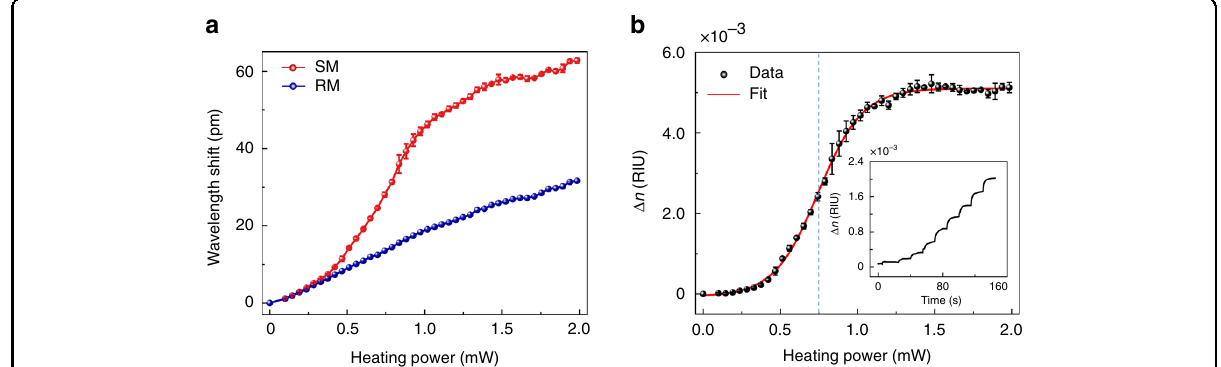
Fig. 4 Steady-state phase transition dynamics. a Dependence of the wavelength shifts of reference mode and sensing mode on the heating light power. b Extracted refractive index change ( Δ n ) of PNIPA solution on the heating light power. Inset: Extracted real-time refractive index change as the heating light power is stepwise